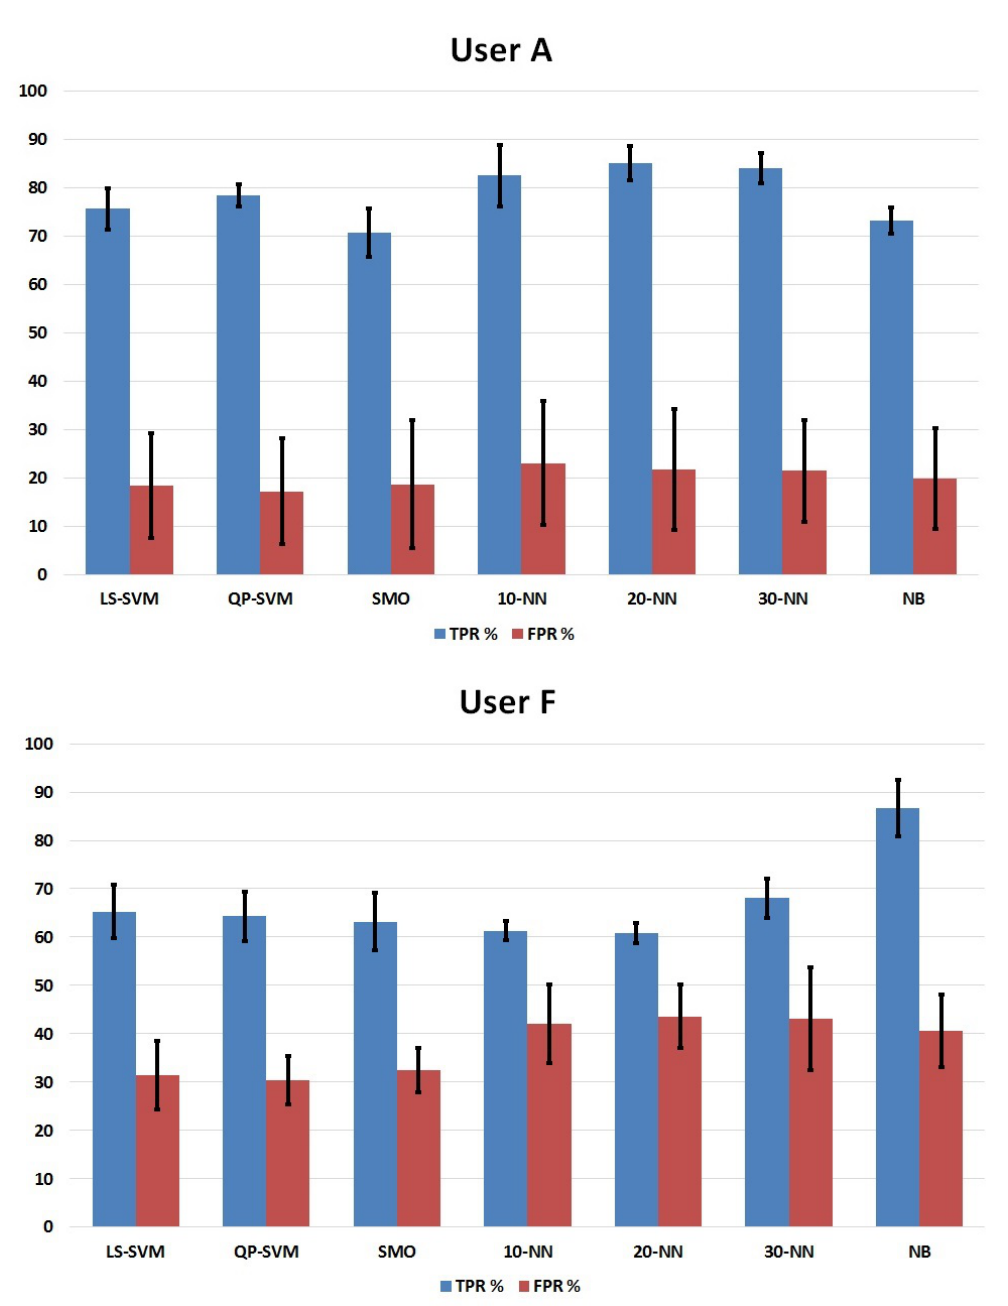
Figure 5. True positive rate (TPR) and false positive rate (FPR) of User A ( top ) and User F ( bottom ) for each